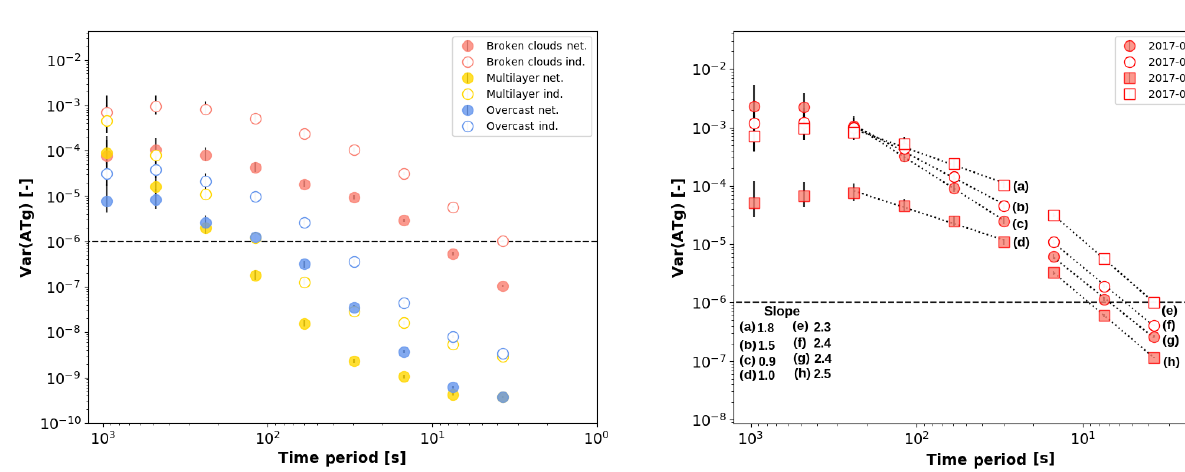
Figure 15. Wavelet-based power spectral density (WSD) of the station-averaged ATg (filled circles) and average WSD from the in- dividual stations (empty circles) for 3h periods (15:00–18:00Z) of broken clouds on 7 June (circles) and 8 June (squares). Solid lines indicate the linear regression for the time period selected, and the dashed horizontal line correspond to the measurement uncertainty of the